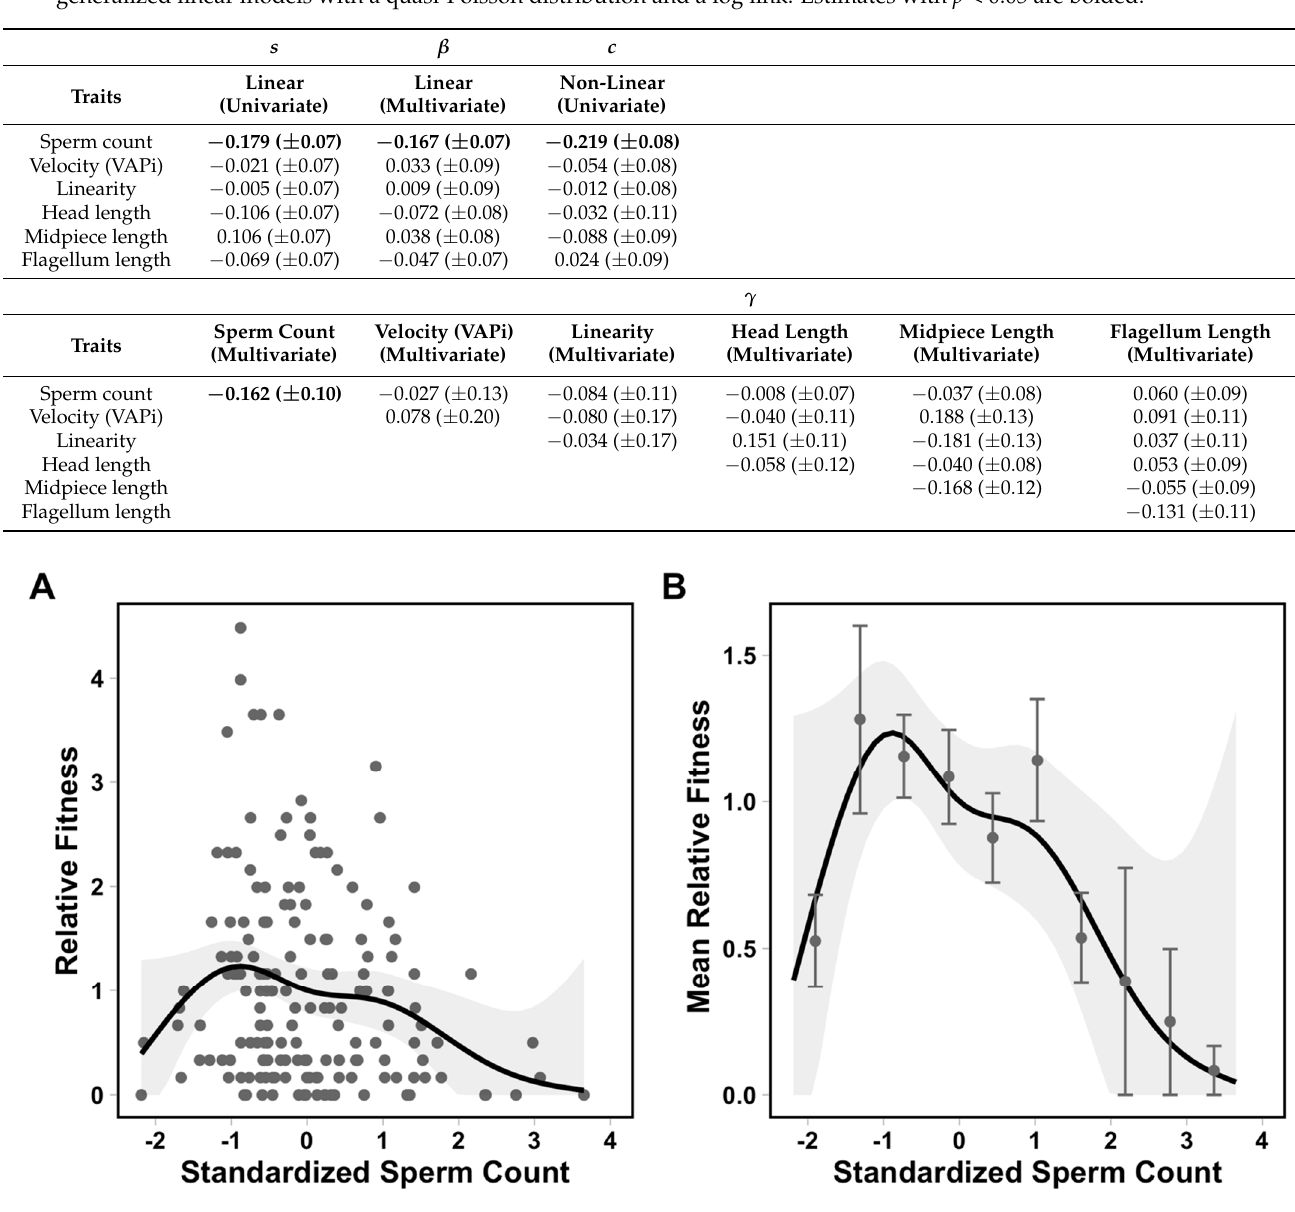
Table 1. Linear and non-linear selection differentials and gradients ( ± SEM) from univariate and multivariate selection analyses, respectively. Estimates were obtained using ordinary least-squares regressions with relative fitness (number of offspring sired relative to population mean) as the dependent variable and standardized male sperm traits and their quadratic terms as the independent variables (separate models were fit for linear and non-linear selection estimates). For estimates of γ , quadratic selection gradients are shown on the diagonal and represent disruptive (+) or stabilizing ( − ) selection on individual traits. Correlational selection gradients are shown above the diagonal and represent selection favoring positive or negative correlations between trait pairs. Significance of selection gradients was determined using generalized linear models with a quasi-Poisson distribution and a log link. Estimates with p < 0.05 are bolded.